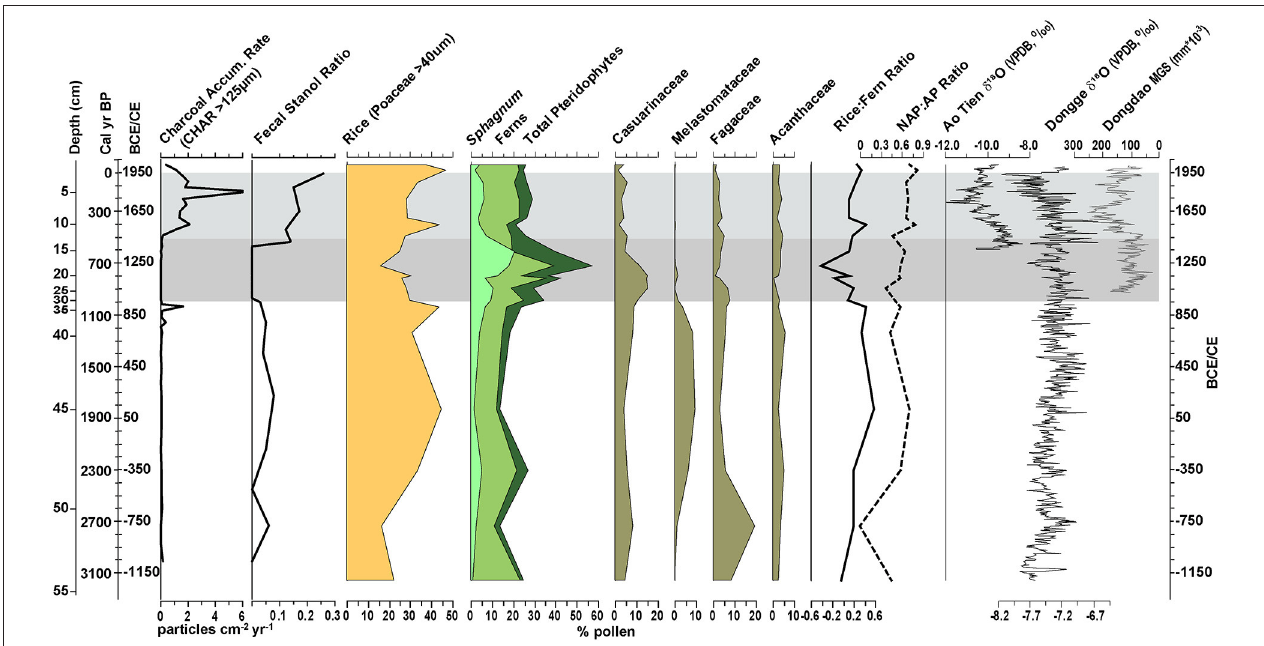
FIGURE 5 | Paleoenvironmental reconstruction. Charcoal accumulation, fecal stanol ratio, and dominant pollen percentages (agricultural:orange; disturbance:green; native:brown). A rice:fern ratio suggests a decline in agriculture during the MCA, and a non-arboreal (NAP):arboreal (AP) ratio indicates fluctuations in native tree species (lower ratio = more native trees) through the record. Regional climate proxies from Ao Tien lake sediments ( δ 18 O; Stevens et al., 2018), northern Vietnam highlands, Dongge Cave speleothem record, southeastern China ( δ 18 O; Dykoski et al., 2005; Wang et al., 2005; Zhao et al., 2015), and mean grain size of Cattle Pond sediments on Dongdao of the Xisha Islands in the South China Sea ( Yan et al., 2011). The light gray band running through the data is the Little Ice Age (LIA) and the dark gray band the Medieval Climate